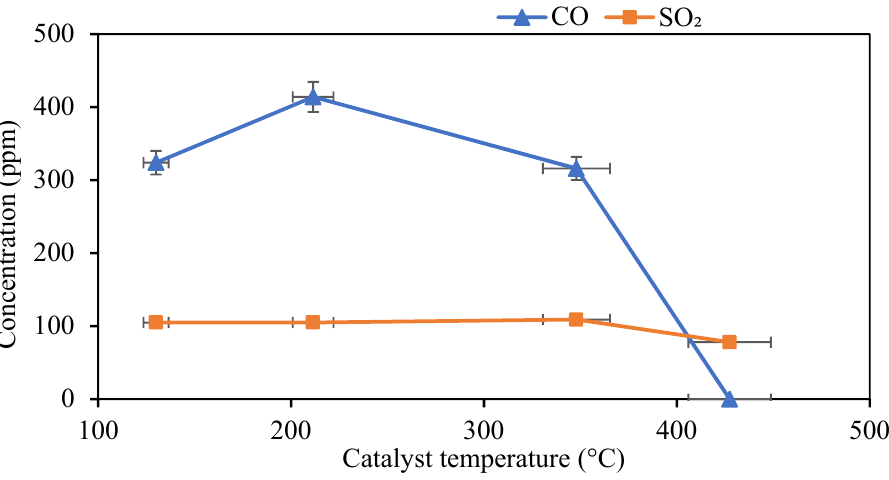
Figure 6. Catalyst temperature effect on CO and SO 2 concentration from JPN combustion at 600 °C.